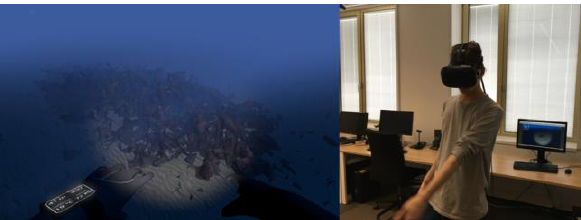
Figure 5. Underwater visualisation of Mazotos shipwreck in immersive